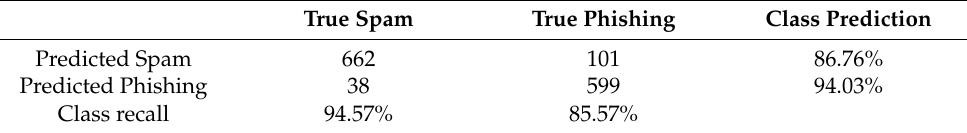
Table 4. Confusion matrix and class prediction as well as class recall values of adjusted parameters for the fast large margin method.